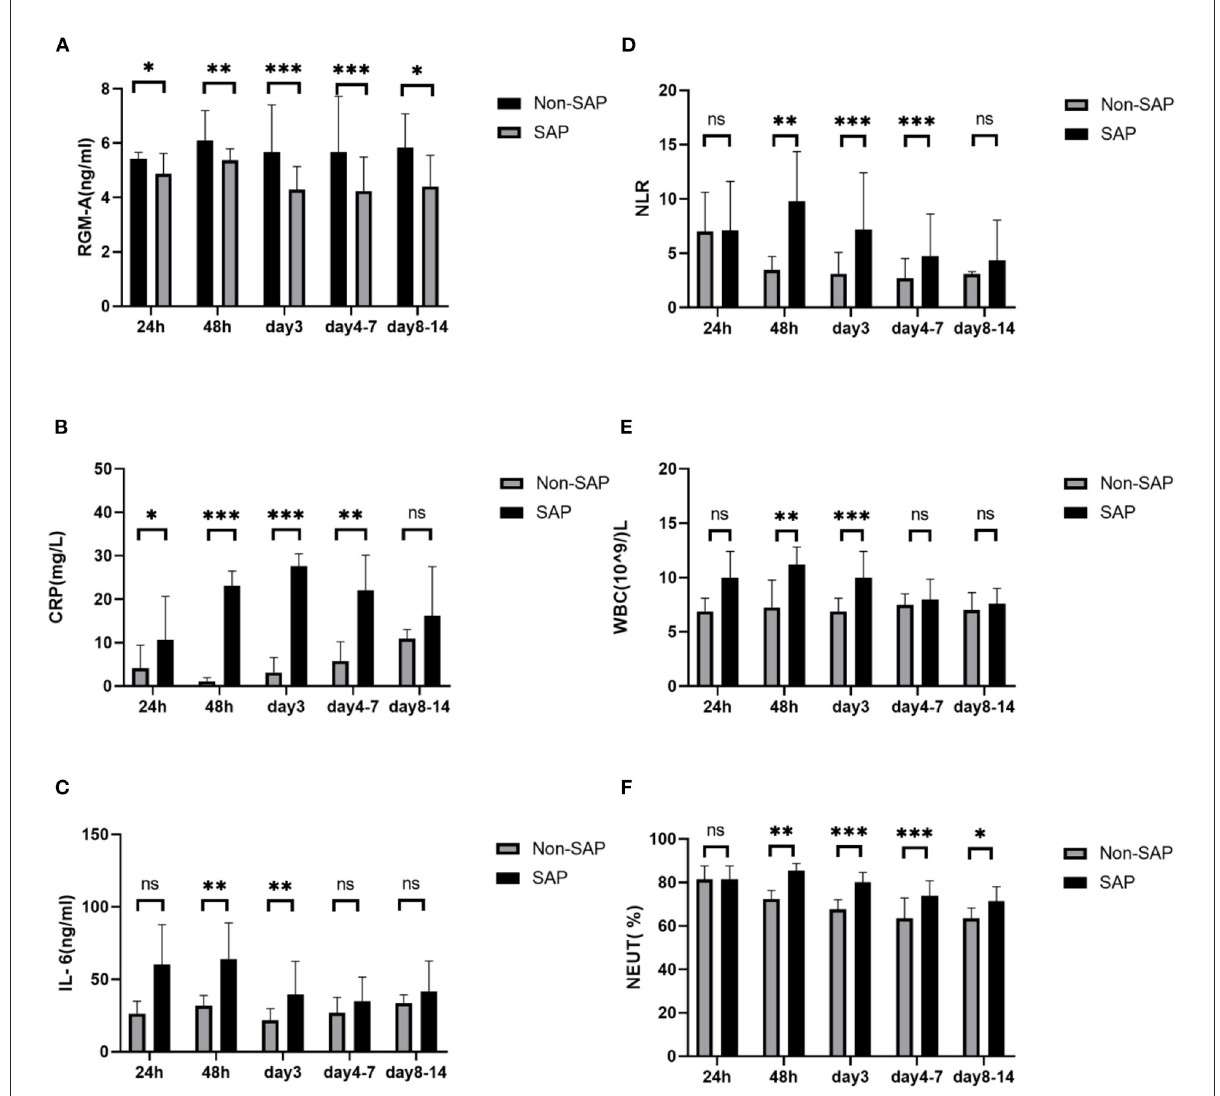
FIGURE3 Levels of RGM-A and inflammatory predictors at 24h, 48h, 3 days, 4 to 7 days, and 8 to 14 days after stroke onset in patients with and without SAP. (A) RGM-A level, (B) CRP level, and (C) IL-6 level in patients with SAP and Non-SAP, (D) NLR, (E) WBC count, and (F) NEUT% in patients with SAP and Non-SAP. SAP: stroke-associated pneumonia; RGM-A: repulsive guidance molecule A; CRP: C-reactive protein; IL-6: interleukin-6; WBC: white blood cell; NLR: neutrophil-to-lymphocyte ratio; NEUT%: percentage of neutrophils. * P < 0.05, ** P < 0.01, and *** P < 0.001; ns, non-significant ( P >